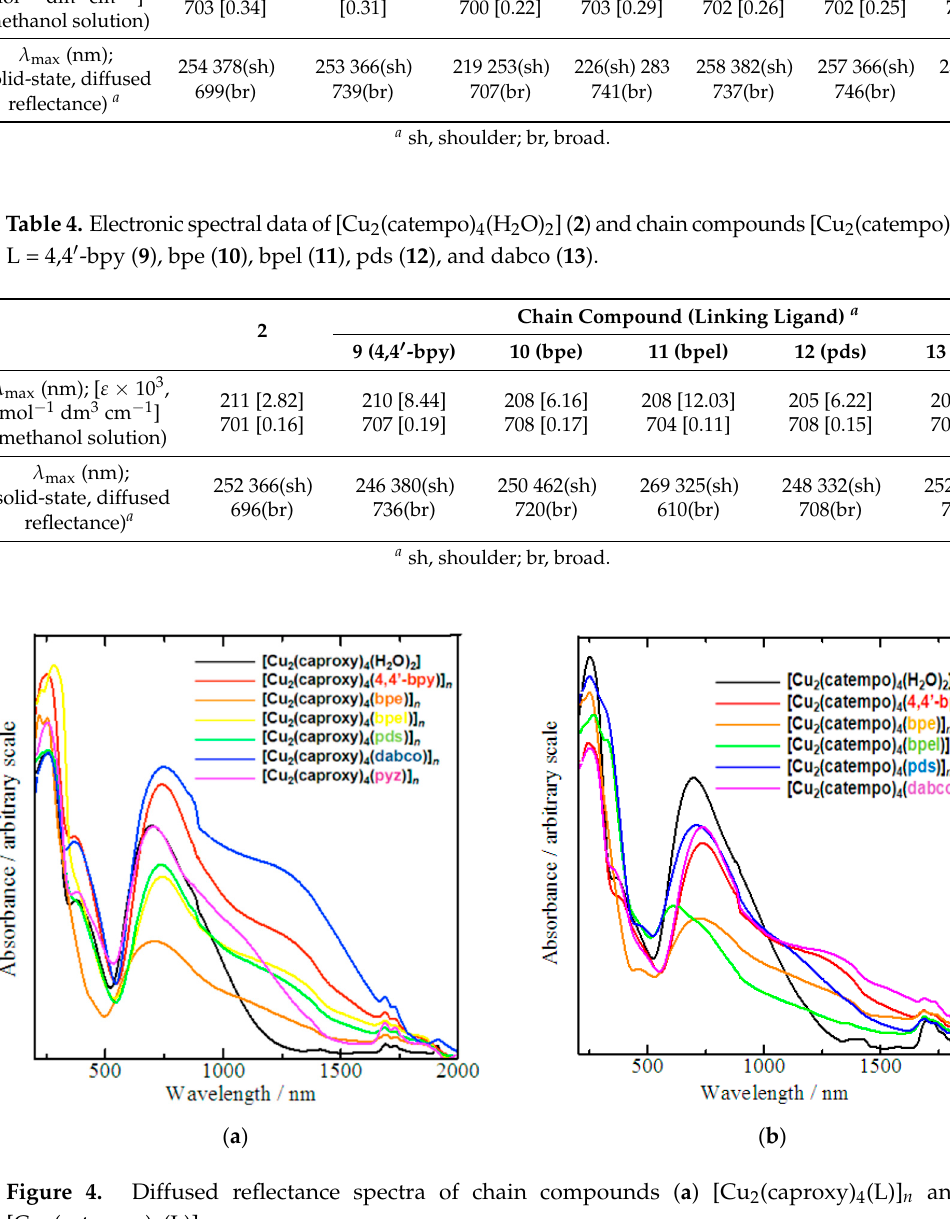
Table 3. Electronic spectral data of [Cu 2 (caproxy) 4 (H 2 O) 2 ] ( 1 ) and chain compounds [Cu 2 (caproxy) 4 (L)] n L = 4,4 (cid:48) -bpy ( 3 ), bpe ( 4 ), bpel ( 5 ), pds ( 6 ), dabco ( 7 ), and pyz ( 8 ).